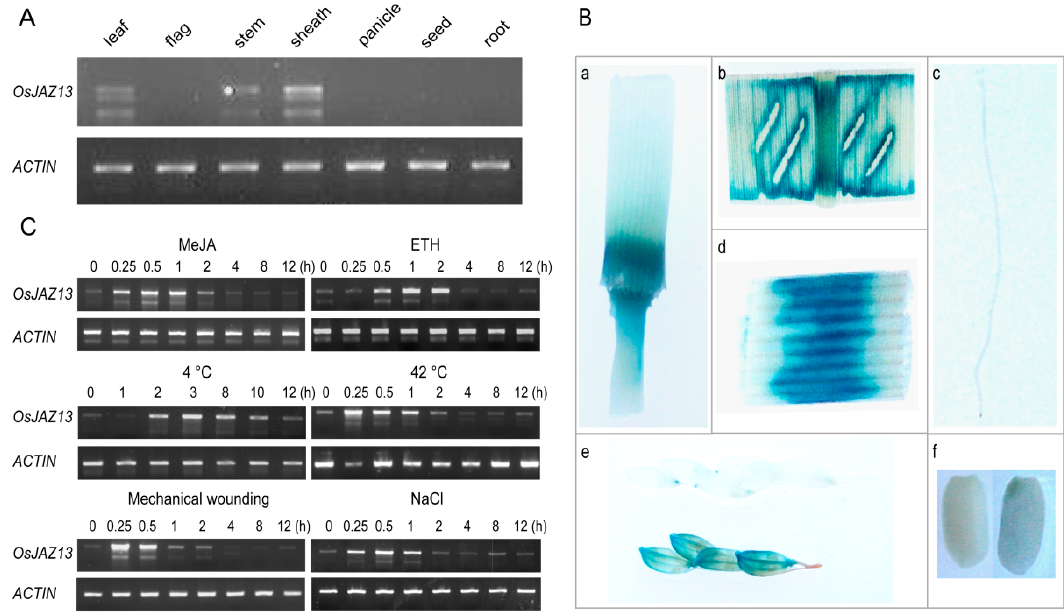
Figure 2. Expression pattern analysis of OsJAZ13 . ( A ) The relative expression of OsJAZ13 in various tissues. RNA was extracted from different organs of MH86, at the seedling and filling stage. ( B ) Expression patterns of OsJAZ13 indicated by β -glucuronidase (GUS) staining. Samples at seedling, flowering, and filling stages were collected, stained, and then photographed with a SONY camera. ( a ) Stem, ( b ) leaf, ( c ) root, ( d ) sheath, ( e ) panicle, and ( f ) seed. ( C ) Three-leaf-stage seedlings of MH86 were treated with 100 µM MeJA (0.1% DMSO dissolved and as mock treatment), 100 µM ethephon (ddH 2 O dissolved and as mock treatment), 4 °C, 42 °C, mechanical wounding, and 200 mM NaCl. Various numbers in this figure represent different time points for sample treatment. Samples were collected at indicated times. ACTIN served as internal control. All experiments were performed for at least three independent biological repeats.